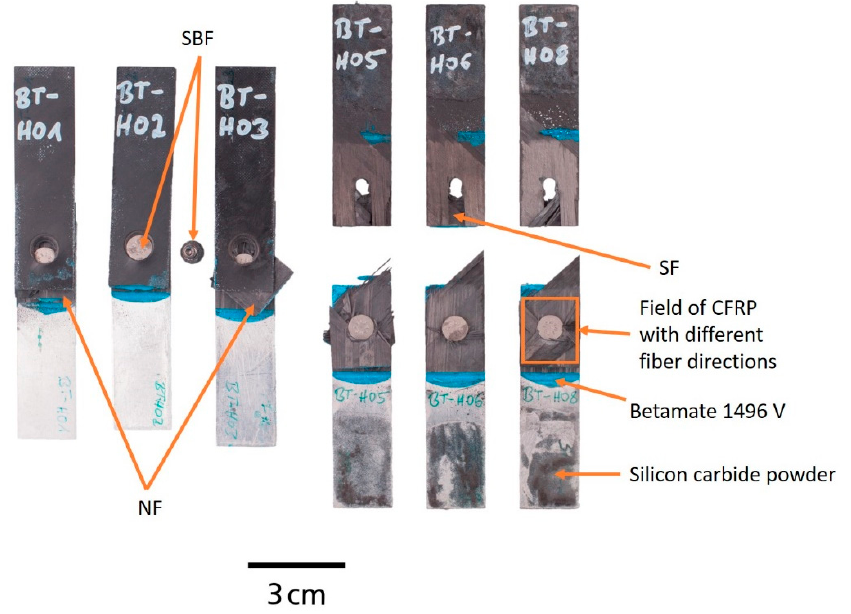
Figure 16. Representative multi-material bonded/bolted joints after testing (NF—net tension failure, SF—shear-out failure, and SBF—bolt shear failure).